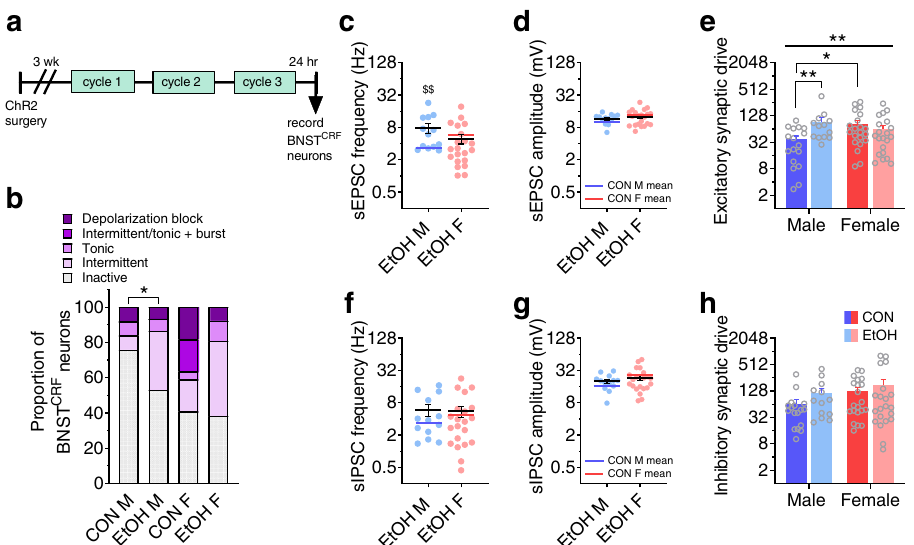
Fig. 6 A history of voluntary binge alcohol drinking induces a female-like phenotype in male BNST CRF neurons. a Experimental timeline for recording from BNST CRF neurons one day following three cycles of alcohol DID (EtOH) or water DID control (CON) procedure (means for CON cell data in Fig. 1 are represented in this fi gure by blue and red lines for CON M and F, respectively). b % BNST CRF neurons in various states of excitability. Chronic alcohol drinking increases the proportion of depolarized neurons in males (Fisher ’ s exact test * P = 0.037) but not females ( P > 0.99). N ’ s = 8 EtOH M, 23 cells; 10 EtOH F, 26 cells. c – h Effect of repeated binge alcohol drinking on spontaneous EPSCs and IPSCs in BNST CRF neurons (N ’ s = 5 EtOH M, 13 cells; 8 EtOH F, 21 cells). c sEPSC frequency. Two-tailed unpaired t -tests: males: t 28 = 3.08, $$ P = 0.005 ; females: t 40 = 1.02, P = 0.314. d sEPSC amplitude. Two-tailed unpaired t -tests: males: t 28 = 1.55, P = 0.132; females: t 40 = 0.520, P = 0.606. e Excitatory synaptic drive, calculated as sEPSC frequency× sEPSC amplitude. 2xANOVA: sex x EtOH interaction ( F 1,68 = 10.55, ** P = 0.002) but no main effects ( P s > 0.05); post hoc two-tailed unpaired t -tests with Holm- Sidak corrections show a sex difference between CON M and F ( t 68 = 3.10, * P = 0.014) and effect of EtOH in males ( t 68 = 3.37, ** P = 0.007) but not females ( P > 0.50). f sIPSC frequency. Two-tailed unpaired t -tests: males: t 28 = 1.48, P = 0.151; females: t 40 = 0.02, P = 0.981. g sIPSC amplitude. Two- tailed unpaired t -tests: males: t 28 = 1.16, P = 0.257; females: t 40 = 1.02, P = 0.314. h Inhibitory synaptic drive. 2xANOVA: no effects or interactions ( P s > 0.30). Data are presented as mean values + SEM.